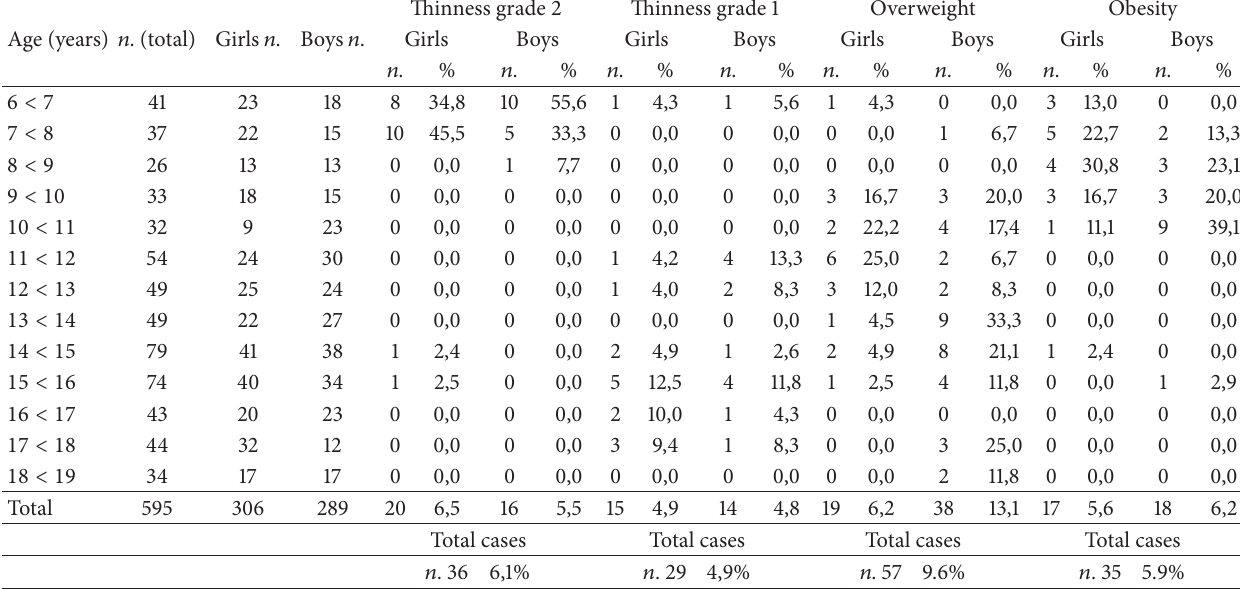
Table 1: Correlation between age groups and BMI. Thinness grade 2 Thinness grade